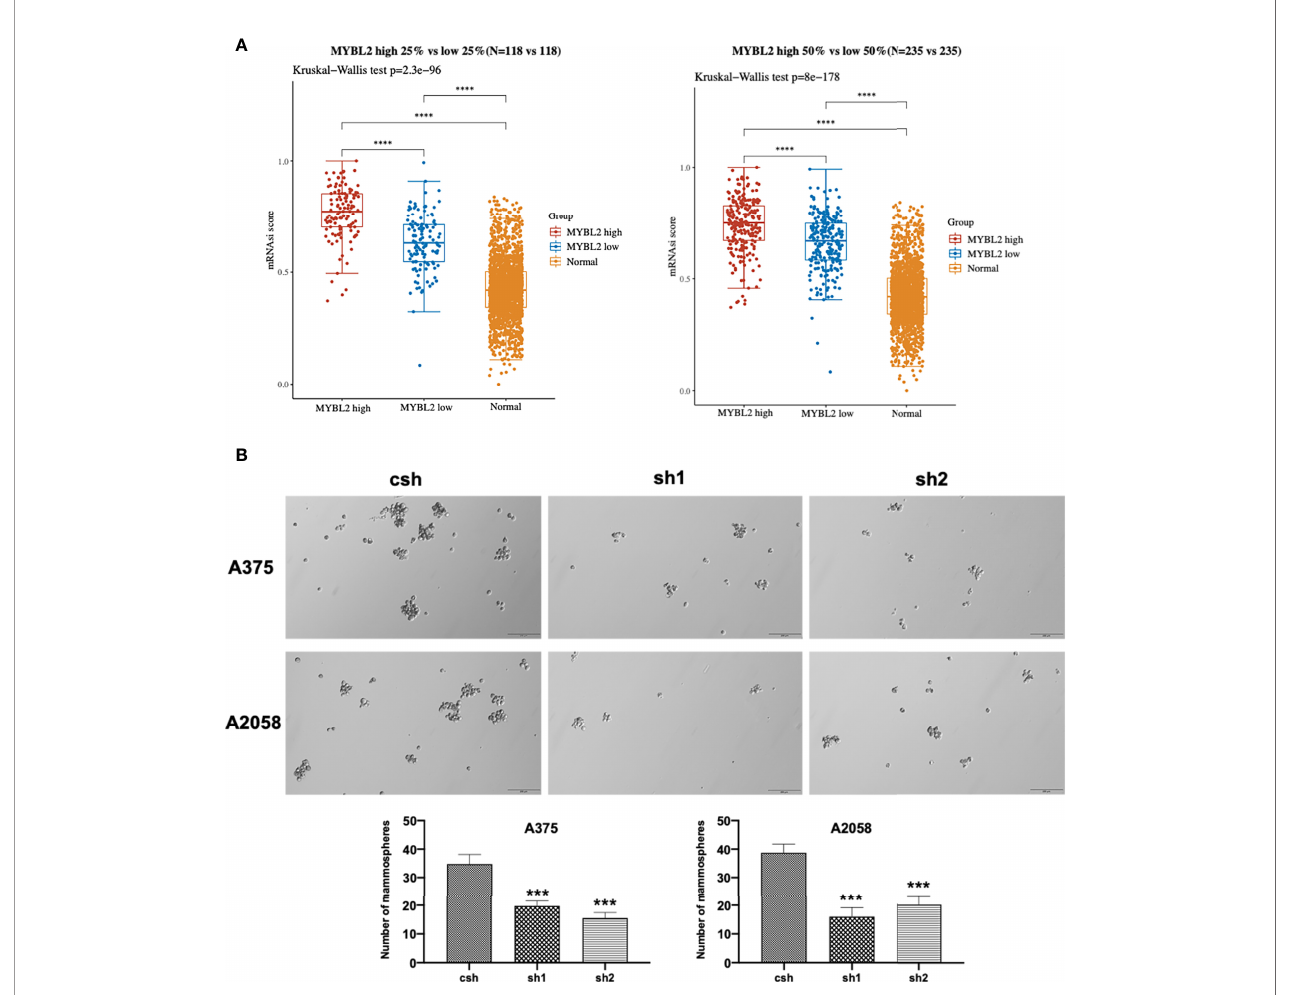
FIGURE 4 | MYBL2 promotes the growth of MSLC populations. (A) The distribution of OCLR scores in different groups, where the horizontal axis represents samples of different groups, and the vertical axis represents the distribution of OCLR scores, where different colors represent different groups. The upper left corner represents the signi fi cance p -value test method. (B) Tumorsphere formation in A375 and A2058 expressing csh or MYBL2 shRNAs (sh1 and sh2). Seven days after seeding, tumorspheres with diameters > 30 m m were counted using Olympus cellSens Standard software. The total numbers of tumorspheres in 6 random fi elds under 10× objective lens were determined for each well. The experiments were repeated at least 3 times. ****p <